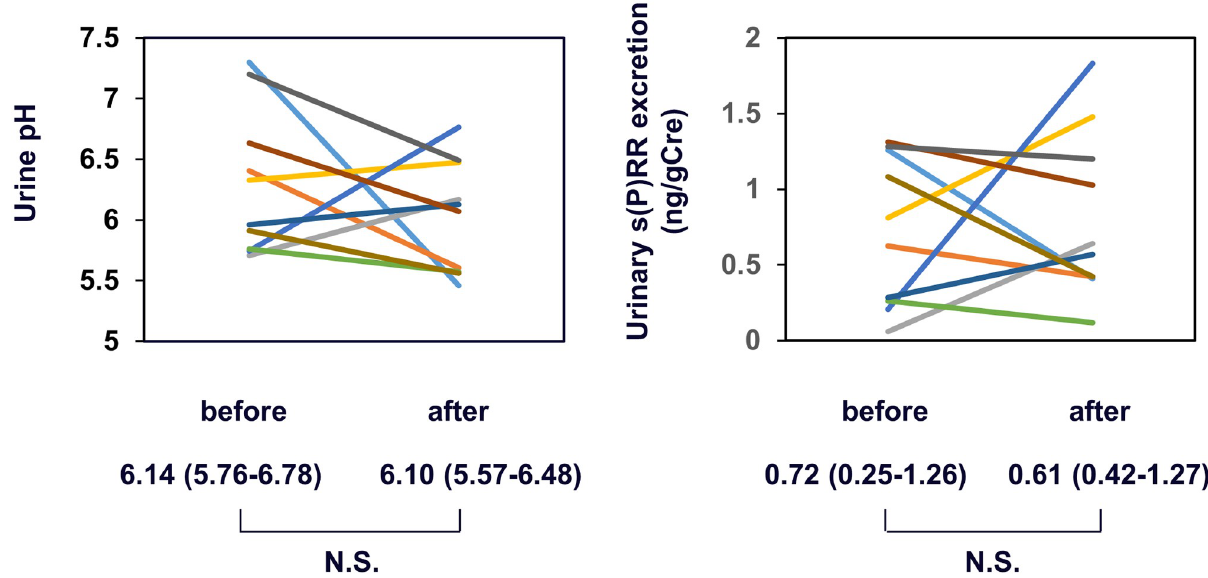
Fig 6. Changes in urine pH or urinary s(P)RR excretion by vitamin C treatment. The same color was used for each of the 10 volunteers. N.S., not significant. s(P)RR, soluble (pro)renin receptor.